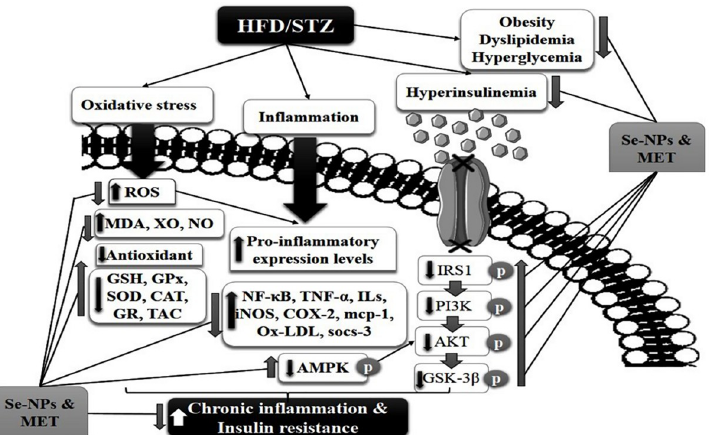
Fig 9. Mechanisms underlying insulin resistance and inflammatory pathway suppression by selenium nanoparticles and metformin. They promote the activation of insulin signaling molecules IRS1/AKT/GSK-3 β . In addition, they enhance the cellular function via AMPK activation. They alleviate diabetic complications by inhibition of stressful stimuli and improve antioxidant capacity. They improve glucose, insulin homeostasis, and lipid metabolism. They exert their anti-inflammatory efficiencies by interrupting the ROS mediated inflammation and down-regulate all inflammatory mediators. ( " ): Up-regulated targets; ( # ) Down-regulated targets.